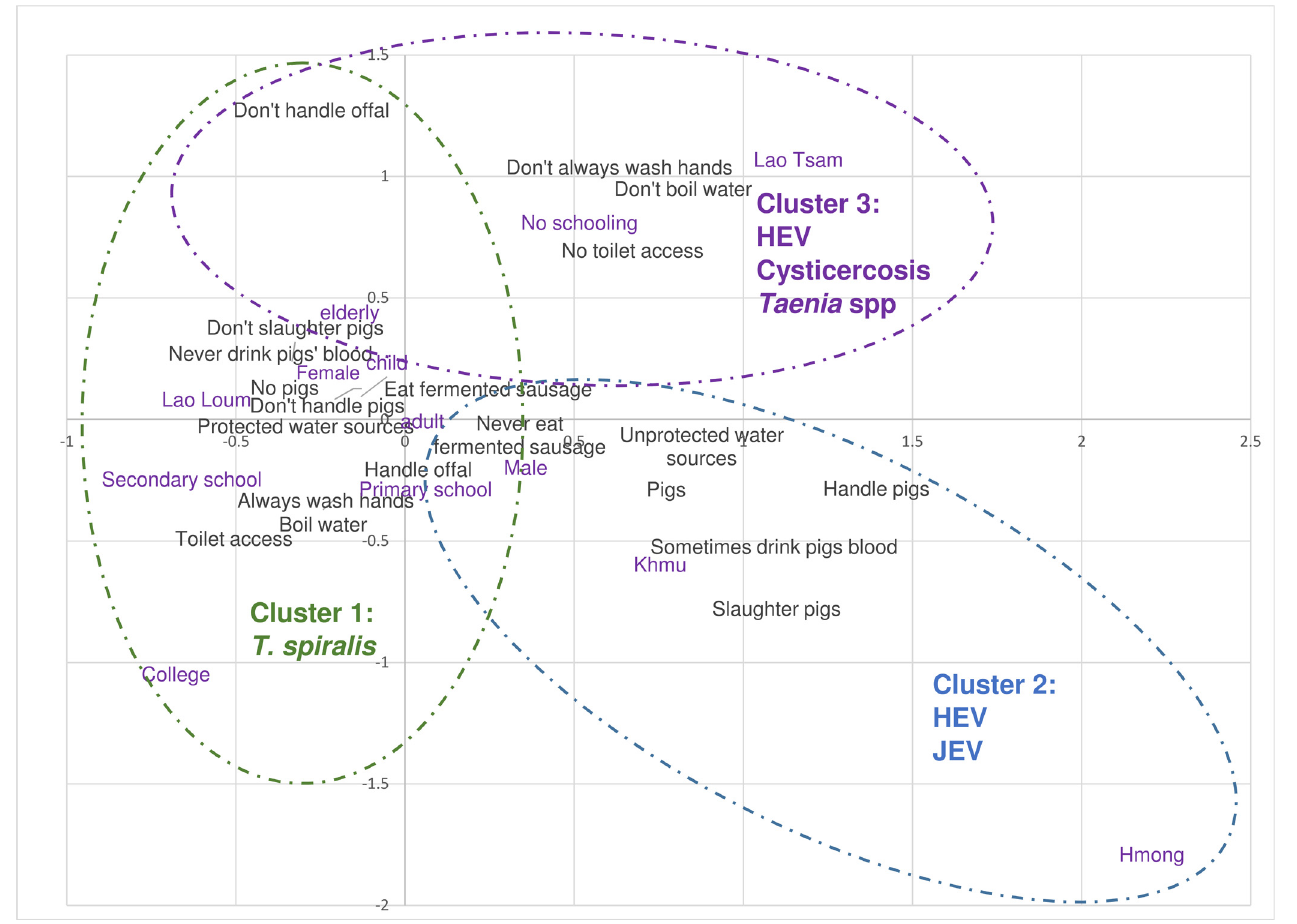
Fig 1. Summary of the results of MCA, HCA and risk factor analysis for pig zoonoses in humans in Lao PDR.